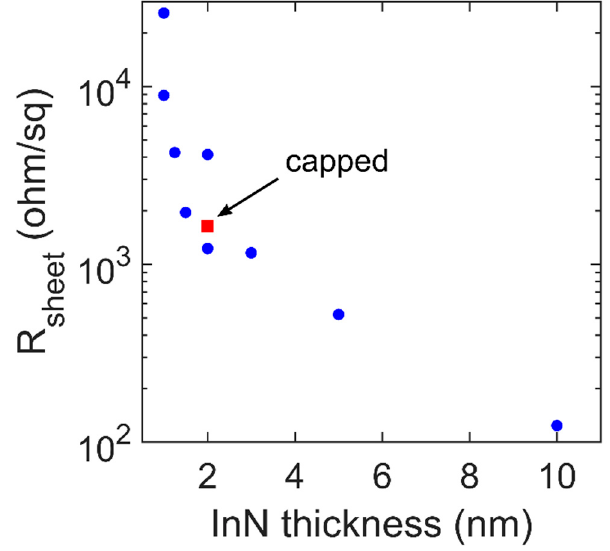
Figure 6. Combined sheet resistance data for processed N-polar InN samples along the a -direction. The red square indicates an InN wire-like sample capped with 6 nm of GaN. The equivalent uncapped sample is the blue circle just below it.